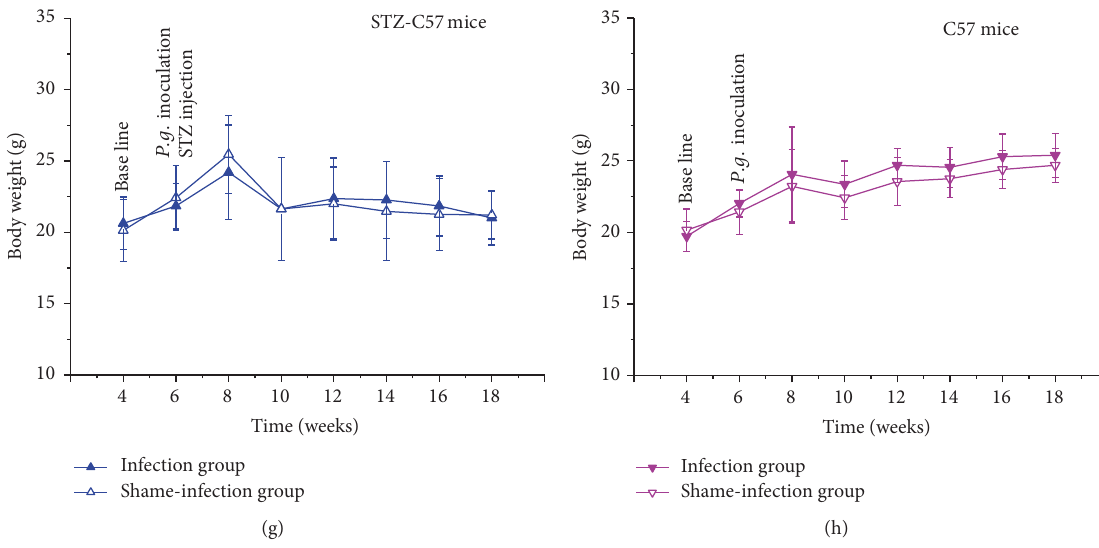
Figure 2: Comparison of fasting blood glucose and body weight levels in different mice: (a, e) db/db mice; (b, f) TH mice; (c, g) STZ-C57 mice; (d, h) C57 mice. No statistical difference ( 𝑃 > 0.05 ) detected for the fasting glucose levels between infection and shame-infection groups in four types of mice. At sacrifice the body weights of infected db/db were significantly higher than their controls ( 𝑃 < 0.01 ). No significant difference was found in the body weight between infection and shame-infection groups in TH, STZ-C57, and C57 mice. Values for each time point are expressed as mean ±